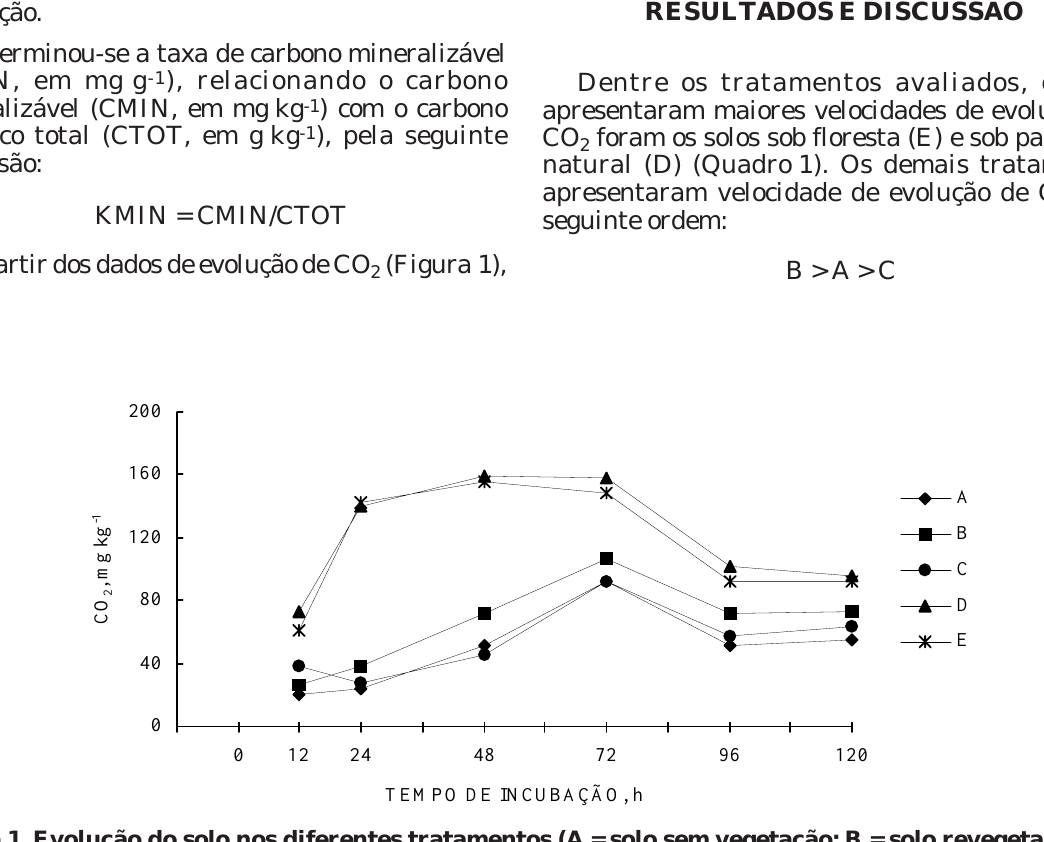
Figura 1. Evolução do solo nos diferentes tratamentos (A = solo sem vegetação; B = solo revegetado com leguminosas; C = solo revegetado com gramínea; D = solo sob pastagem natural e E = solo sob floresta), em função do tempo de